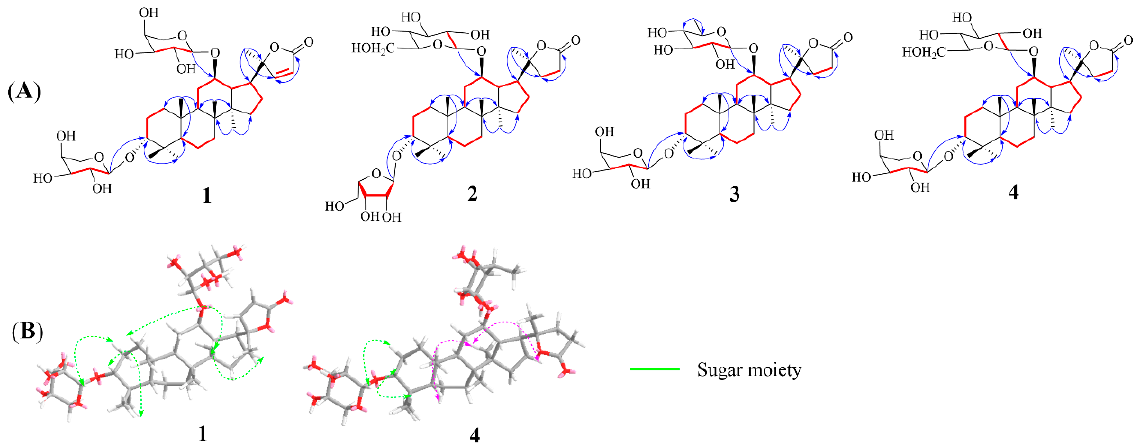
Figure 2. ( A ) Key HMBC (red arrows) and COSY (blue bold bonds) correlations of compounds 1 – 4 . ( B ) ROESY correlations of compounds 1 and 4 . Table 1. 1 H and 13 C NMR spectral data of compounds 1 – 2 (600 MHz, Pyridine- d 5 , δ in ppm). Table 2. The HPLC retention time of sugar moieties of compounds 1 – 4 . 1 2 Types of the Compounds Retention Times (min) Position Monosaccharides δ H , Mult ( J in Hz) 1 6.844, 6.847 L-Ara, L-Ara